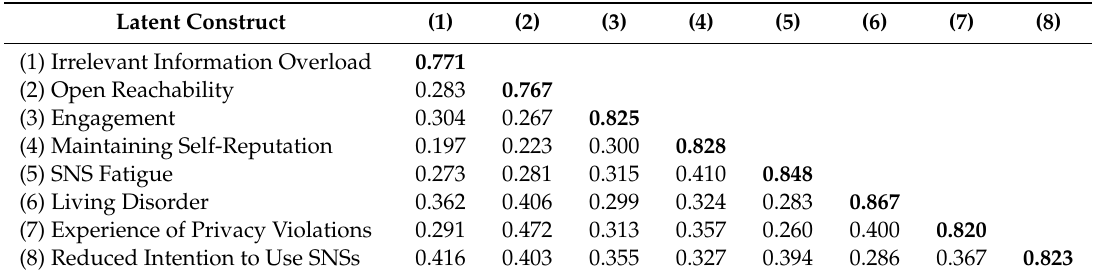
Table 7. Discriminant validity